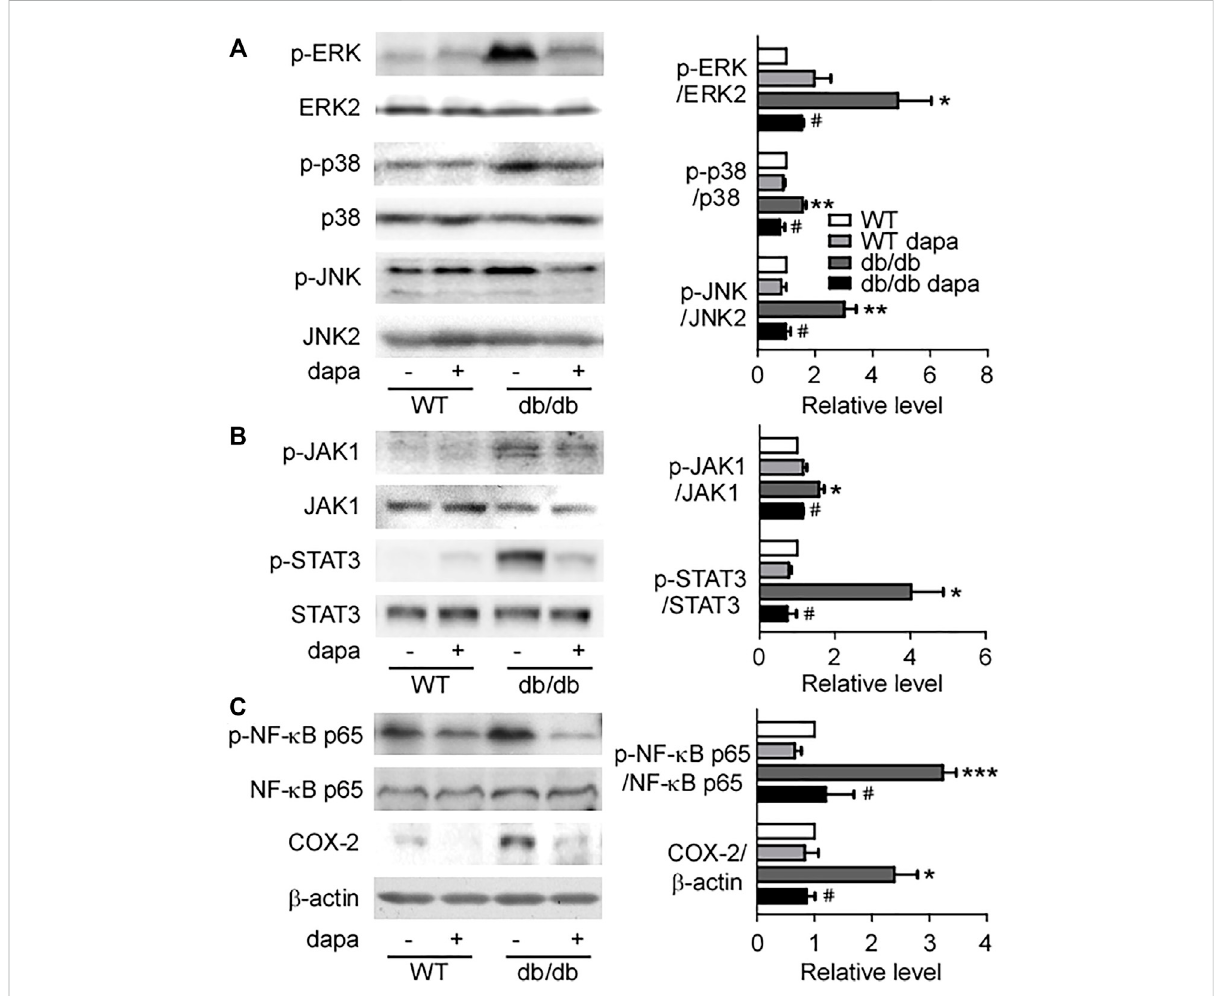
FIGURE 4 Dapagli fl ozin inhibited hepatic in fl ammatory response in db/db mice. (A) Representative western blotting ( left ) and quanti fi cation of protein levels ( right ) of ERK, p38, and JNK of livers. (B) Representative western blotting ( left ) and quanti fi cation of protein levels ( right ) of JAK1 and STAT3 of livers. (C) Representativewesternblotting( left )andquanti fi cationofproteinlevels( right )ofNF- κ Bp65andCOX-2oflivers.Valuesweremean±SEM, n = 3. * p < 0.05, ** p < 0.01, and *** p < 0.001 vs. wild-type (WT) mice. # p < 0.05 vs. db/db mice. One-way ANOVA, Bonferroni ’ s